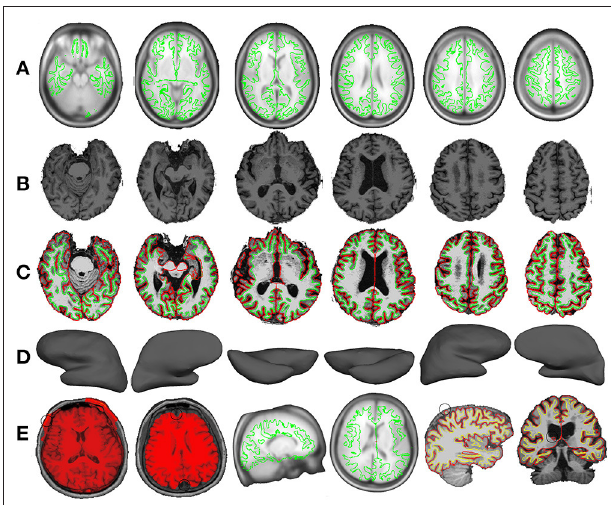
FIGURE 4 | A set of pictures for checking the quality of talairach transform (A) , skull strip (B) , surface reconstruction (C,D) . The illustration of “bad” quality (E) includes skull strip failure (donated by black circles), talairach transform failure and surface construction failure (indicated by black